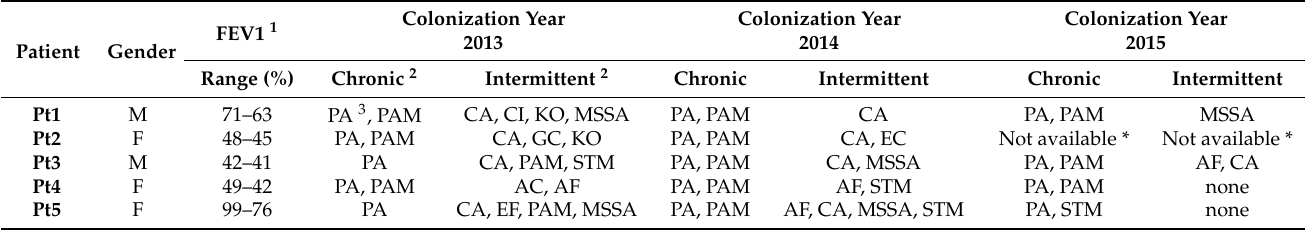
Table 1. Microbiological status of the enrolled patients monitored over the 3-year